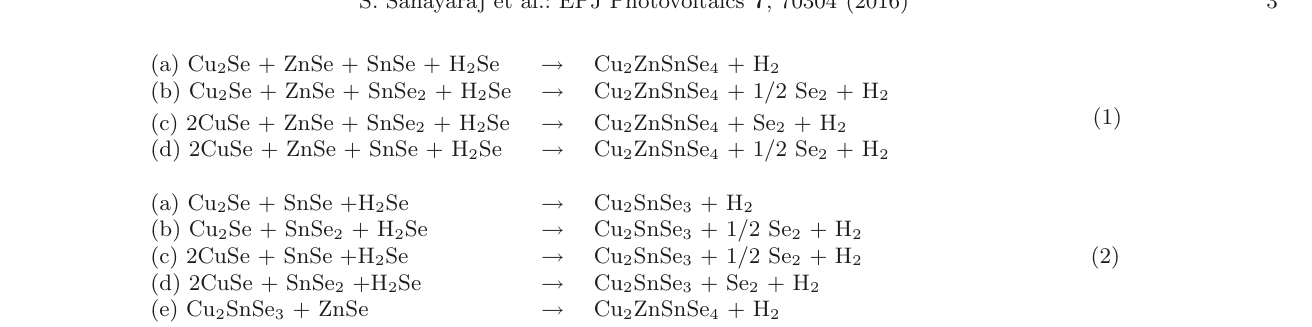
Table 1. Dataset S1. Table 2. Dataset S2.